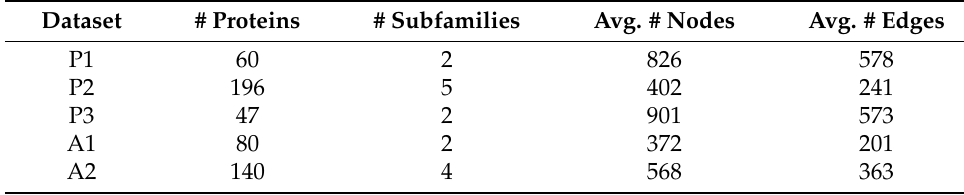
Table 2. Average properties of proteins in all